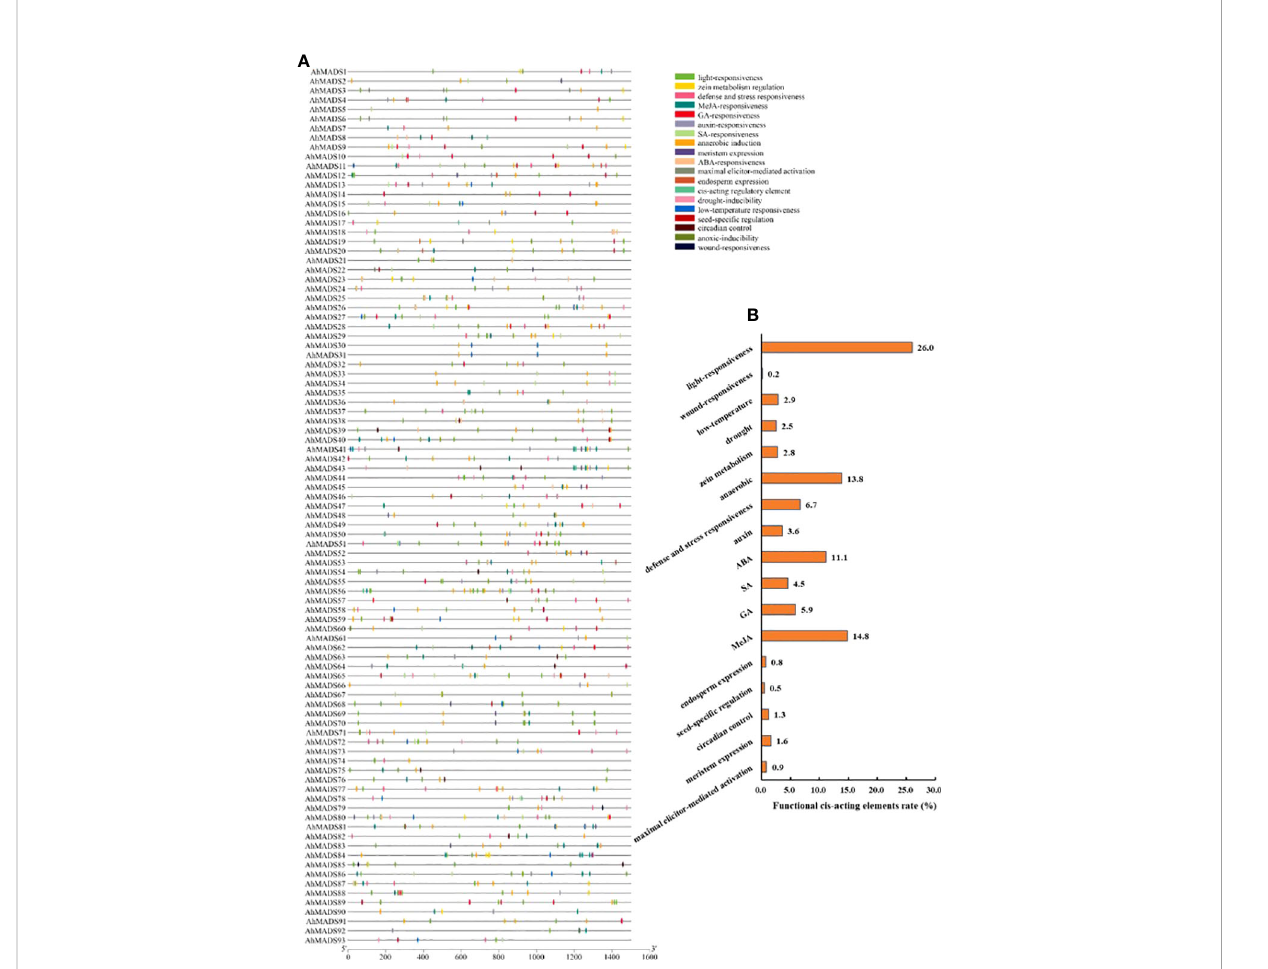
FIGURE 6 Cis-acting regulatory elements in the peanut MADS-box gene promoters. (A) The distribution of cis-acting elements in the promoter of each peanut MADS-box. (B) Various functional cis-acting elements are shown with different colors in the pie